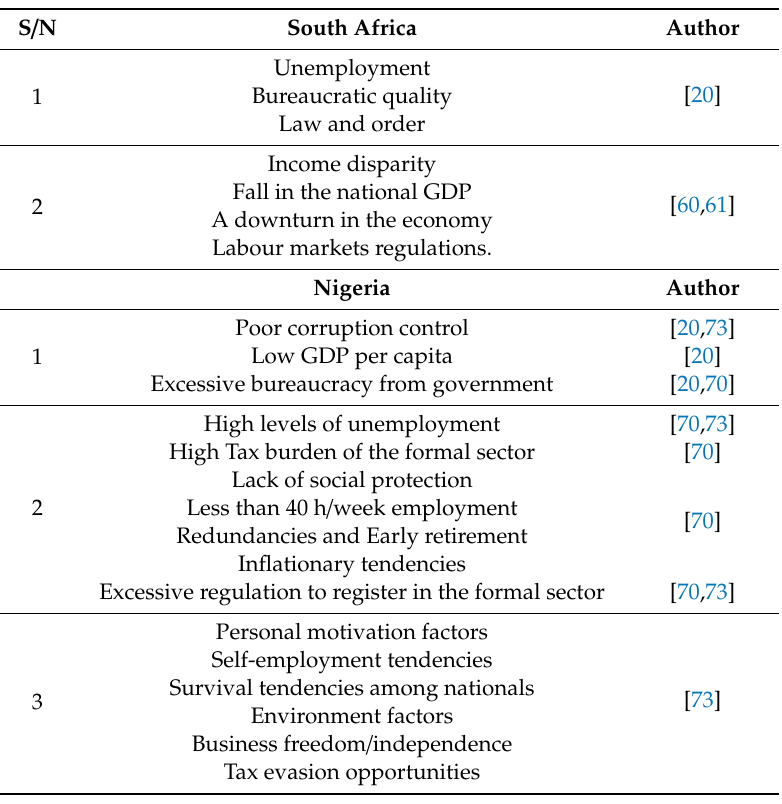
Table 11. Causes of informality in South Africa and Nigeria.